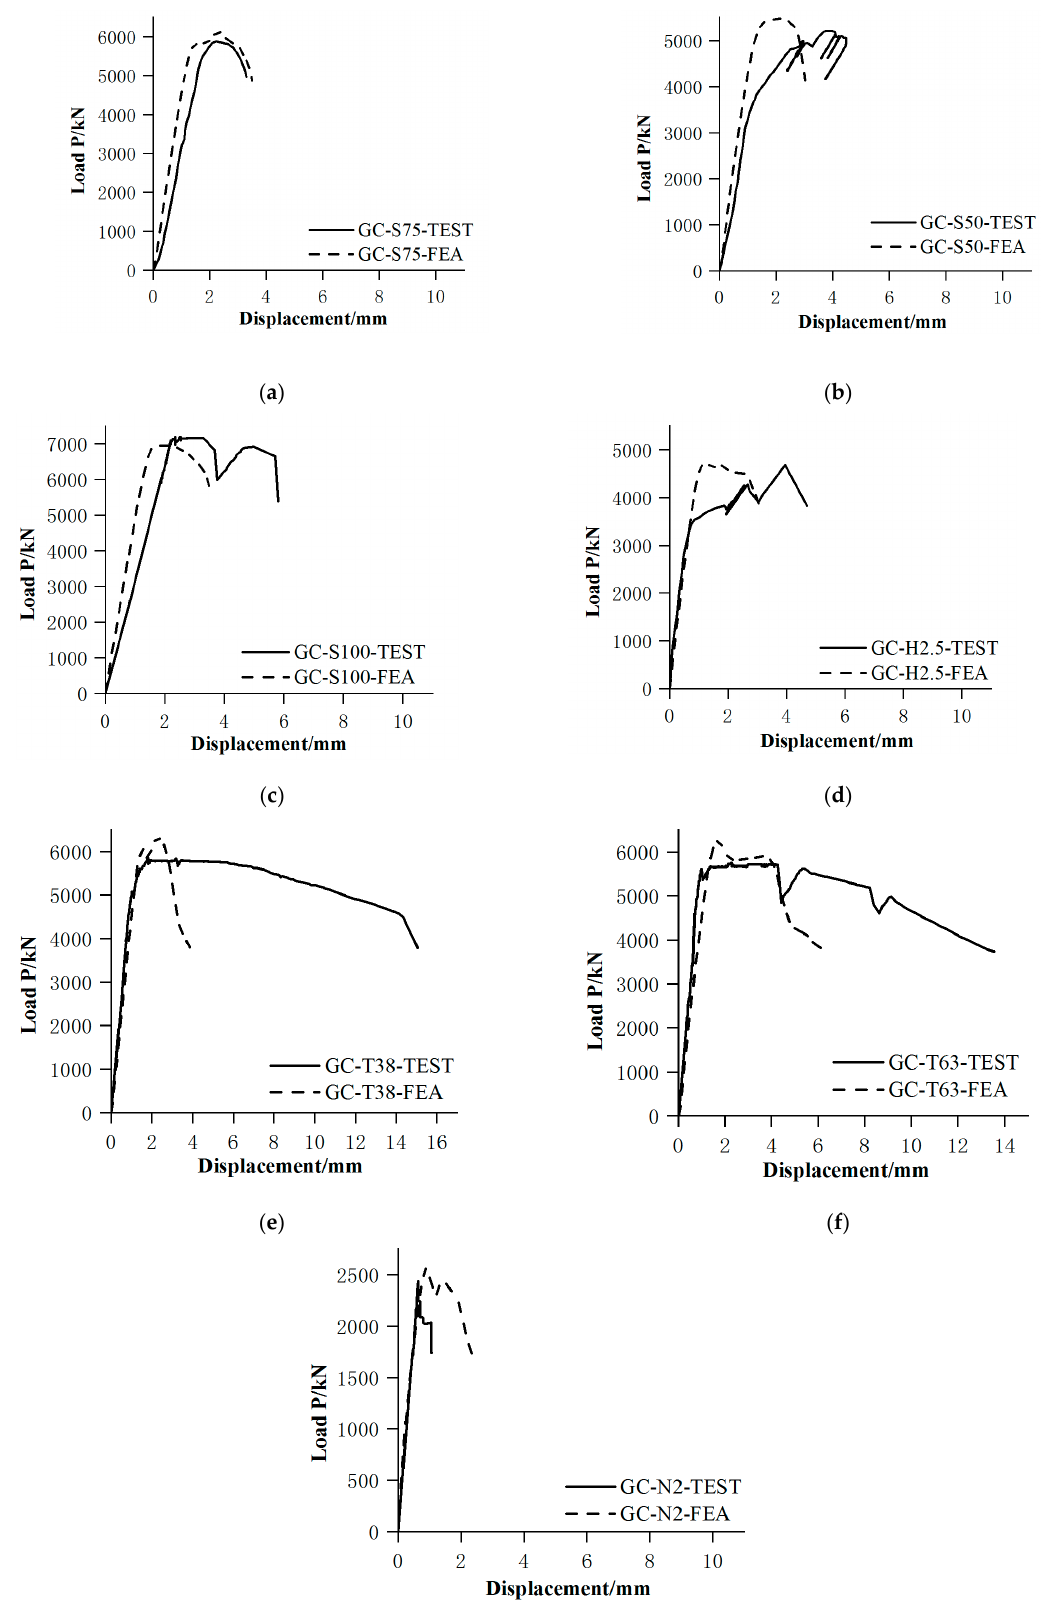
Figure 12. Comparison of test load–displacement curves: ( a ) S75; ( b ) S50; ( c ) S100; ( d ) H2.5; ( e ) T38; ( f ) T63; ( g ) N2.